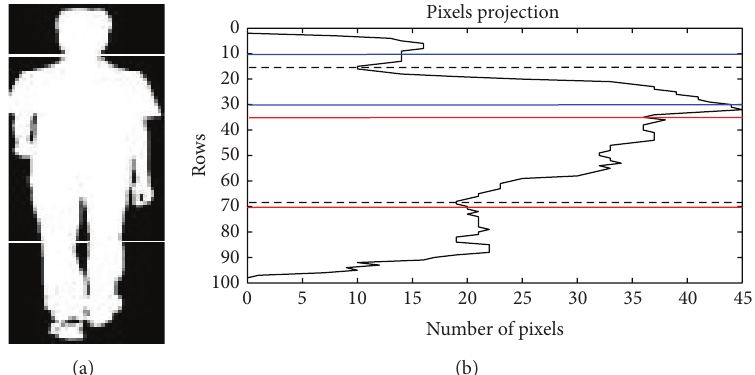
Figure 7: The region segmentation of an object. (a) represents the head torso and leg region and (b) depicts the horizontal projection, with the minimum points of head and torso highlighted with the dotted lines.